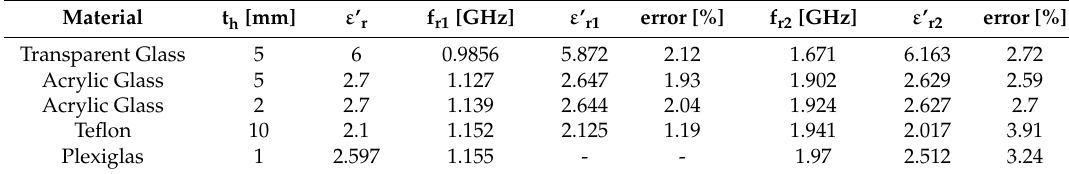
Table 2. Real part of the complex permittivity for di ff erent materials under test.